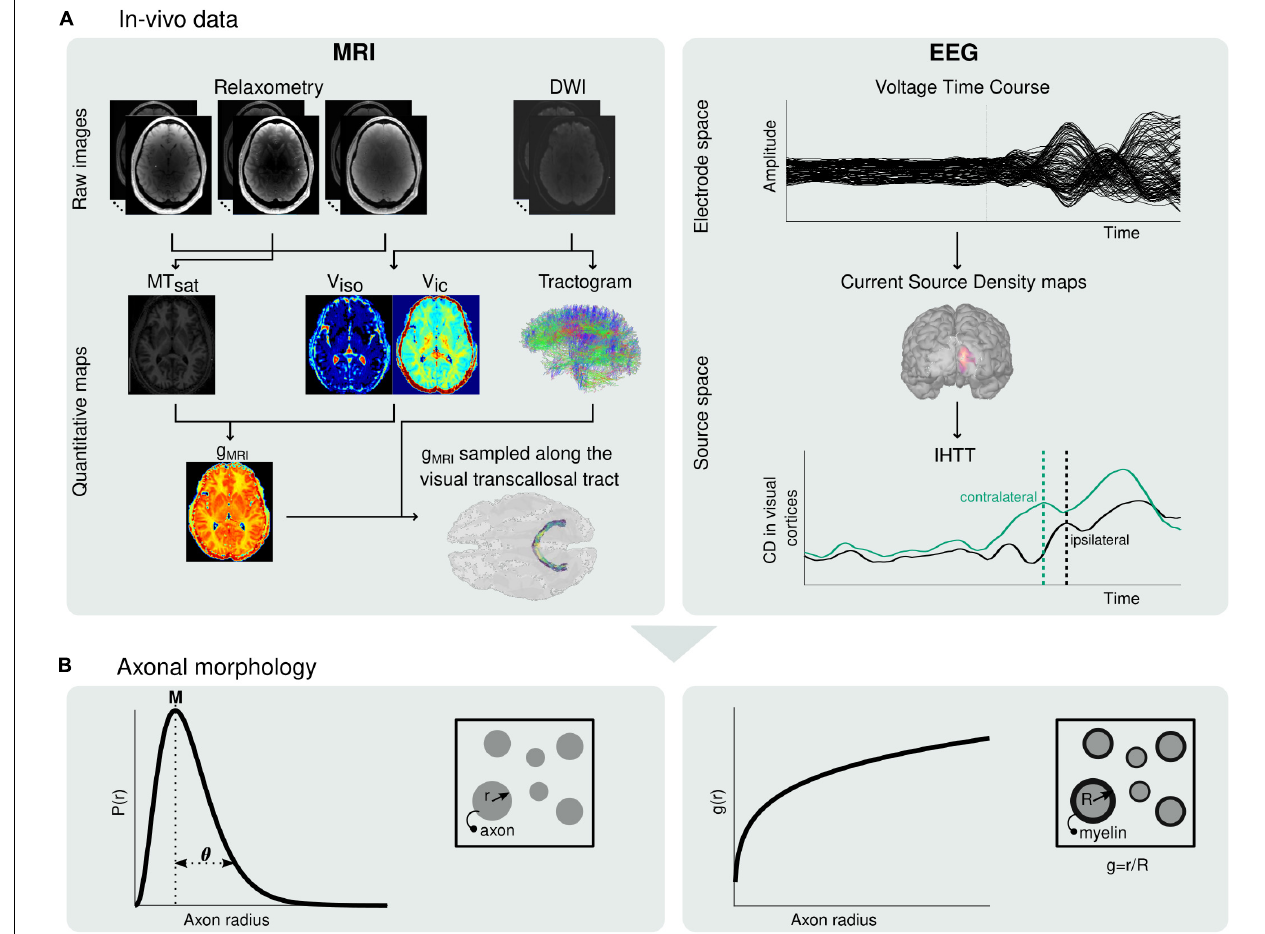
FIGURE 1 | Estimation of microscopic morphological properties of axons from in vivo MRI and EEG data. (A) Maps of MT sat , v iso and v ic are computed from the raw MRI data and subsequently used to compute maps of the MRI-measured g-ratio ( g MRI ) (left). The MRI-measured g-ratio maps are sampled along the visual transcallosal tract using the streamlines obtained with diffusion MRI tractography. Estimation of the IHTT is performed after source reconstruction of the EEG data, based on the difference in latency between the two maxima of activation at the two hemispheres observed on the group-averaged current source time course (right). (B) The g MRI and IHTT estimates are used to estimate morphological properties of axons within the visual transcallosal tract axonal radius distribution [ P ( r ) , left] and axonal g-ratio [ g ( r ) ,